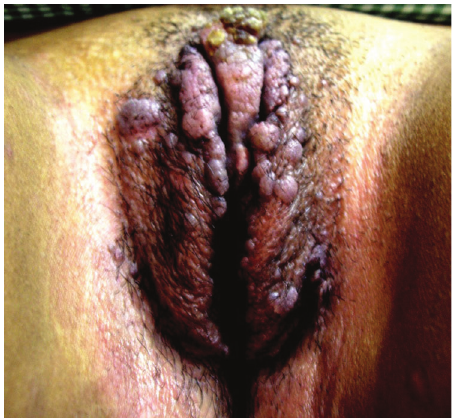
Figure 1 - Multiple and confluent warts on the